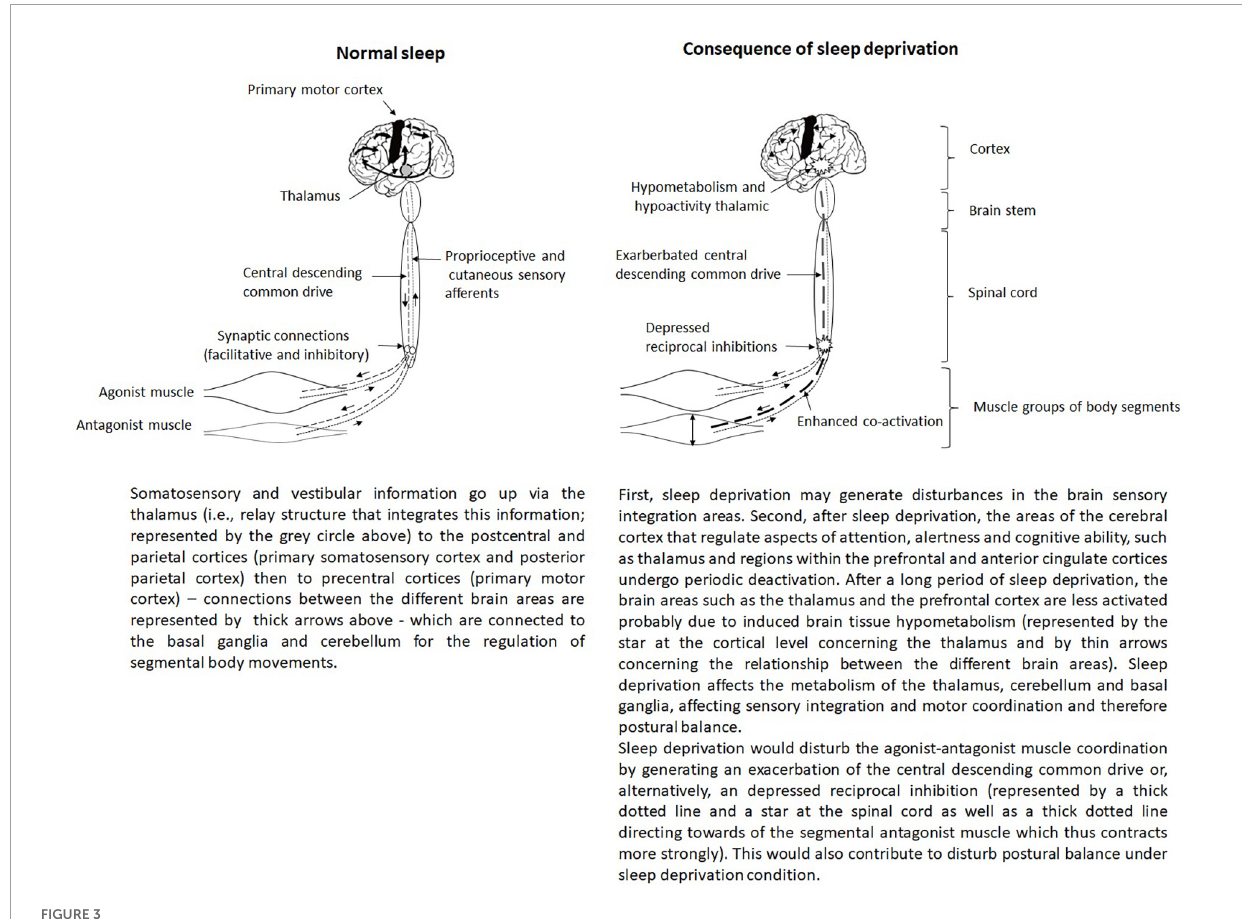
vertical, which is important in the process of postural balance regulation (Martin et al.,